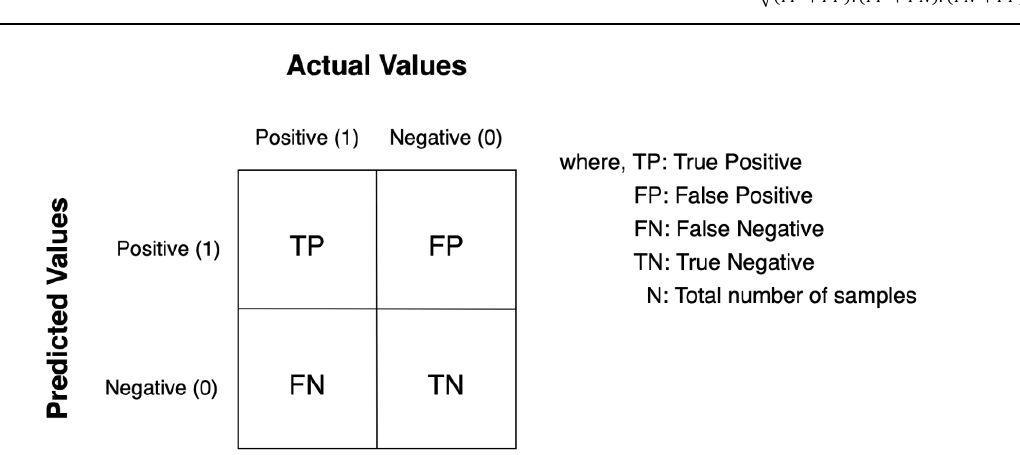
Figure 5. Confusion matrix for